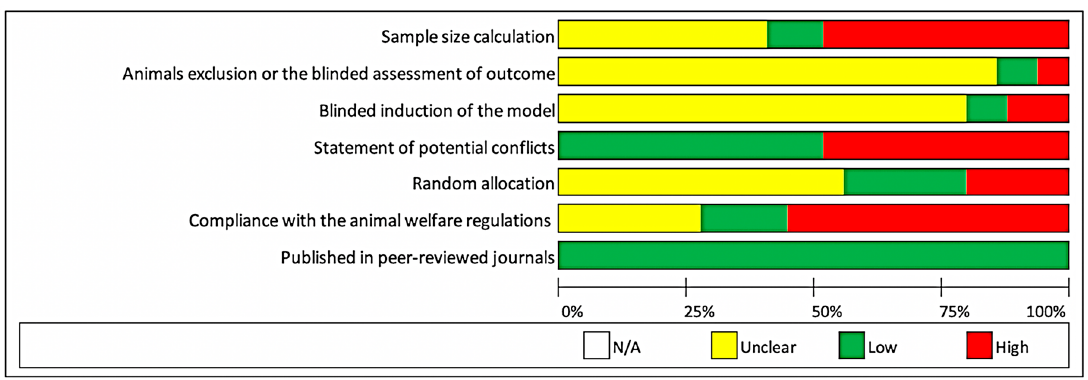
Figure 4. Quality assessment of studies using the CAMARADES study quality checklist.